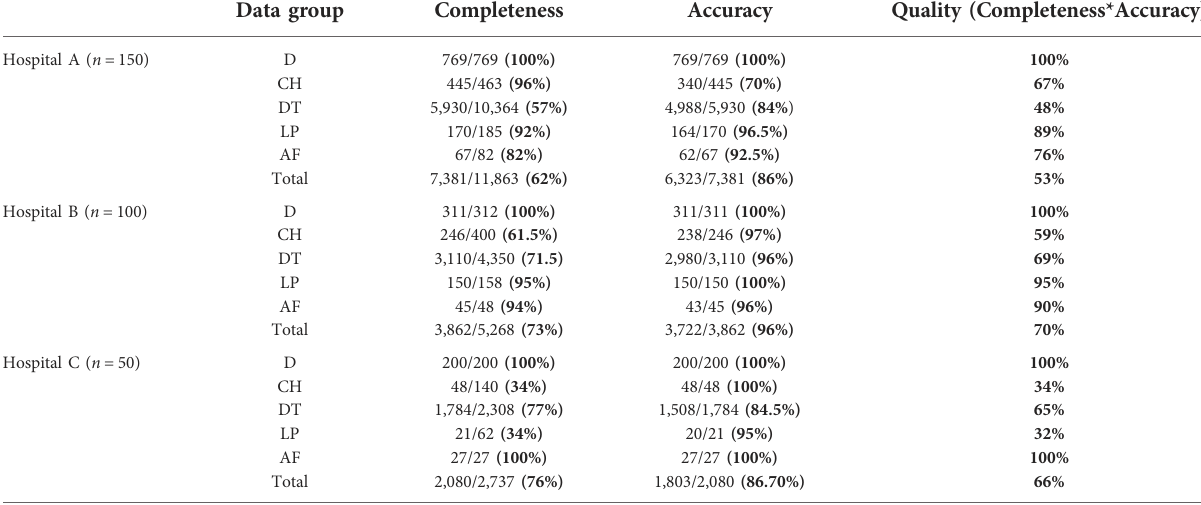
TABLE 5 Completeness, accuracy and quality of research and educational data